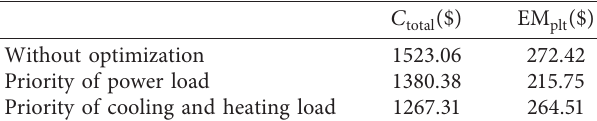
Table 11: Comparison of optimization